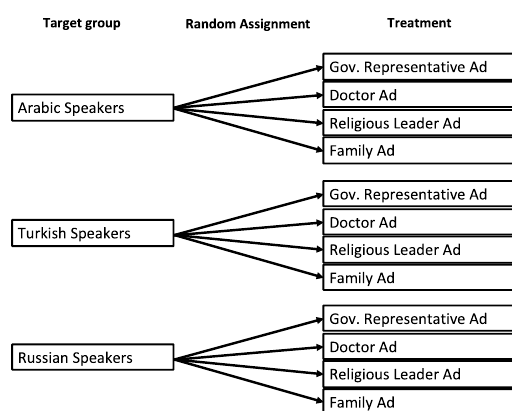
Cost effectiveness. The total (non-staff) cost for the 29-day campaign was 6,455 EUR, 0.007€ per person reached by an advertisement. The cost per person who accessed the vaccination appointment tool linked in the advertisement was 0.43€ per person, equivalent to 2.3 individuals for every one euro spent on the campaign. Dividing the costs for the advertisements by the number of assumed vaccinations (i.e. from estimated conver- sation rates) yields a per-vaccination cost of 8 EUR for the 10% scenario and 4 EUR for the 20% scenario (see appendix, Table S2). The campaign cost was slightly higher for older users above 55 years as well as for female users compared to male users. The cost also varied by language group. For example, the cost to engage Russian speakers was almost three times as high compared to the cost for Arabic speakers (appendix, Table S2). The effect of native‑language outreach. Compared to the German-only COVID-19 vaccination advertisements, significantly higher click-through rates were seen with vaccine advertisements translated to Arabic ( p < 0.001) and Russian ( p < 0.001) among these respective language user groups. There was less of a dif- ference between German and Turkish language advertisements ( p = 0.315; see Fig. 3) for the Turkish speaking group. In Germany, Arabic- and Russian-speakers were 2.4 (95% confidence interval [CI]: 1.9; 2.9) and 1.8 times (95% CI: 1.3; 2.4) more likely to click on vaccine advertisement in their respective languages compared to Ger- man language advertisements (see Table 2). The effect of the messenger.